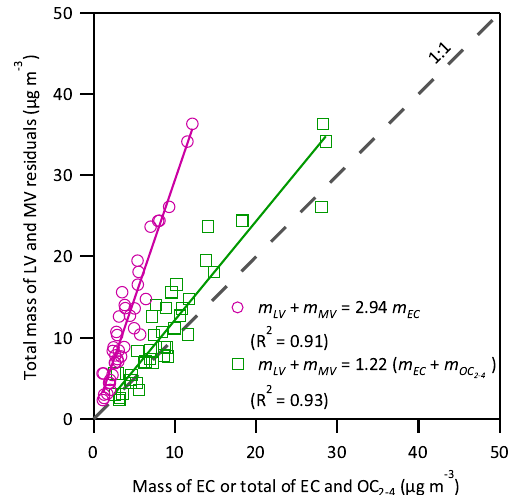
Figure 12. A closure analysis of the total mass of LV and MV resid- uals from VTDMA at 300 ◦ C and measured mass of EC or total of EC and OC 2 − 4 from the OC / EC analyzer.